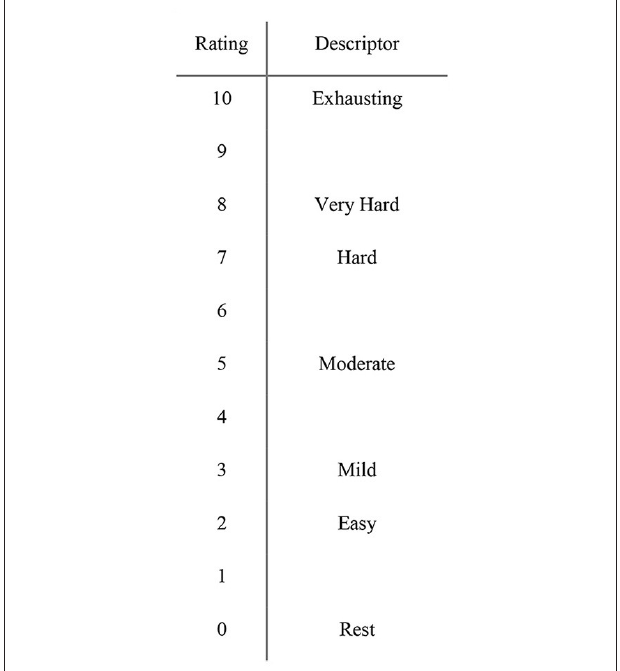
FIGURE 1 | The new Global Session Metric (GSM)